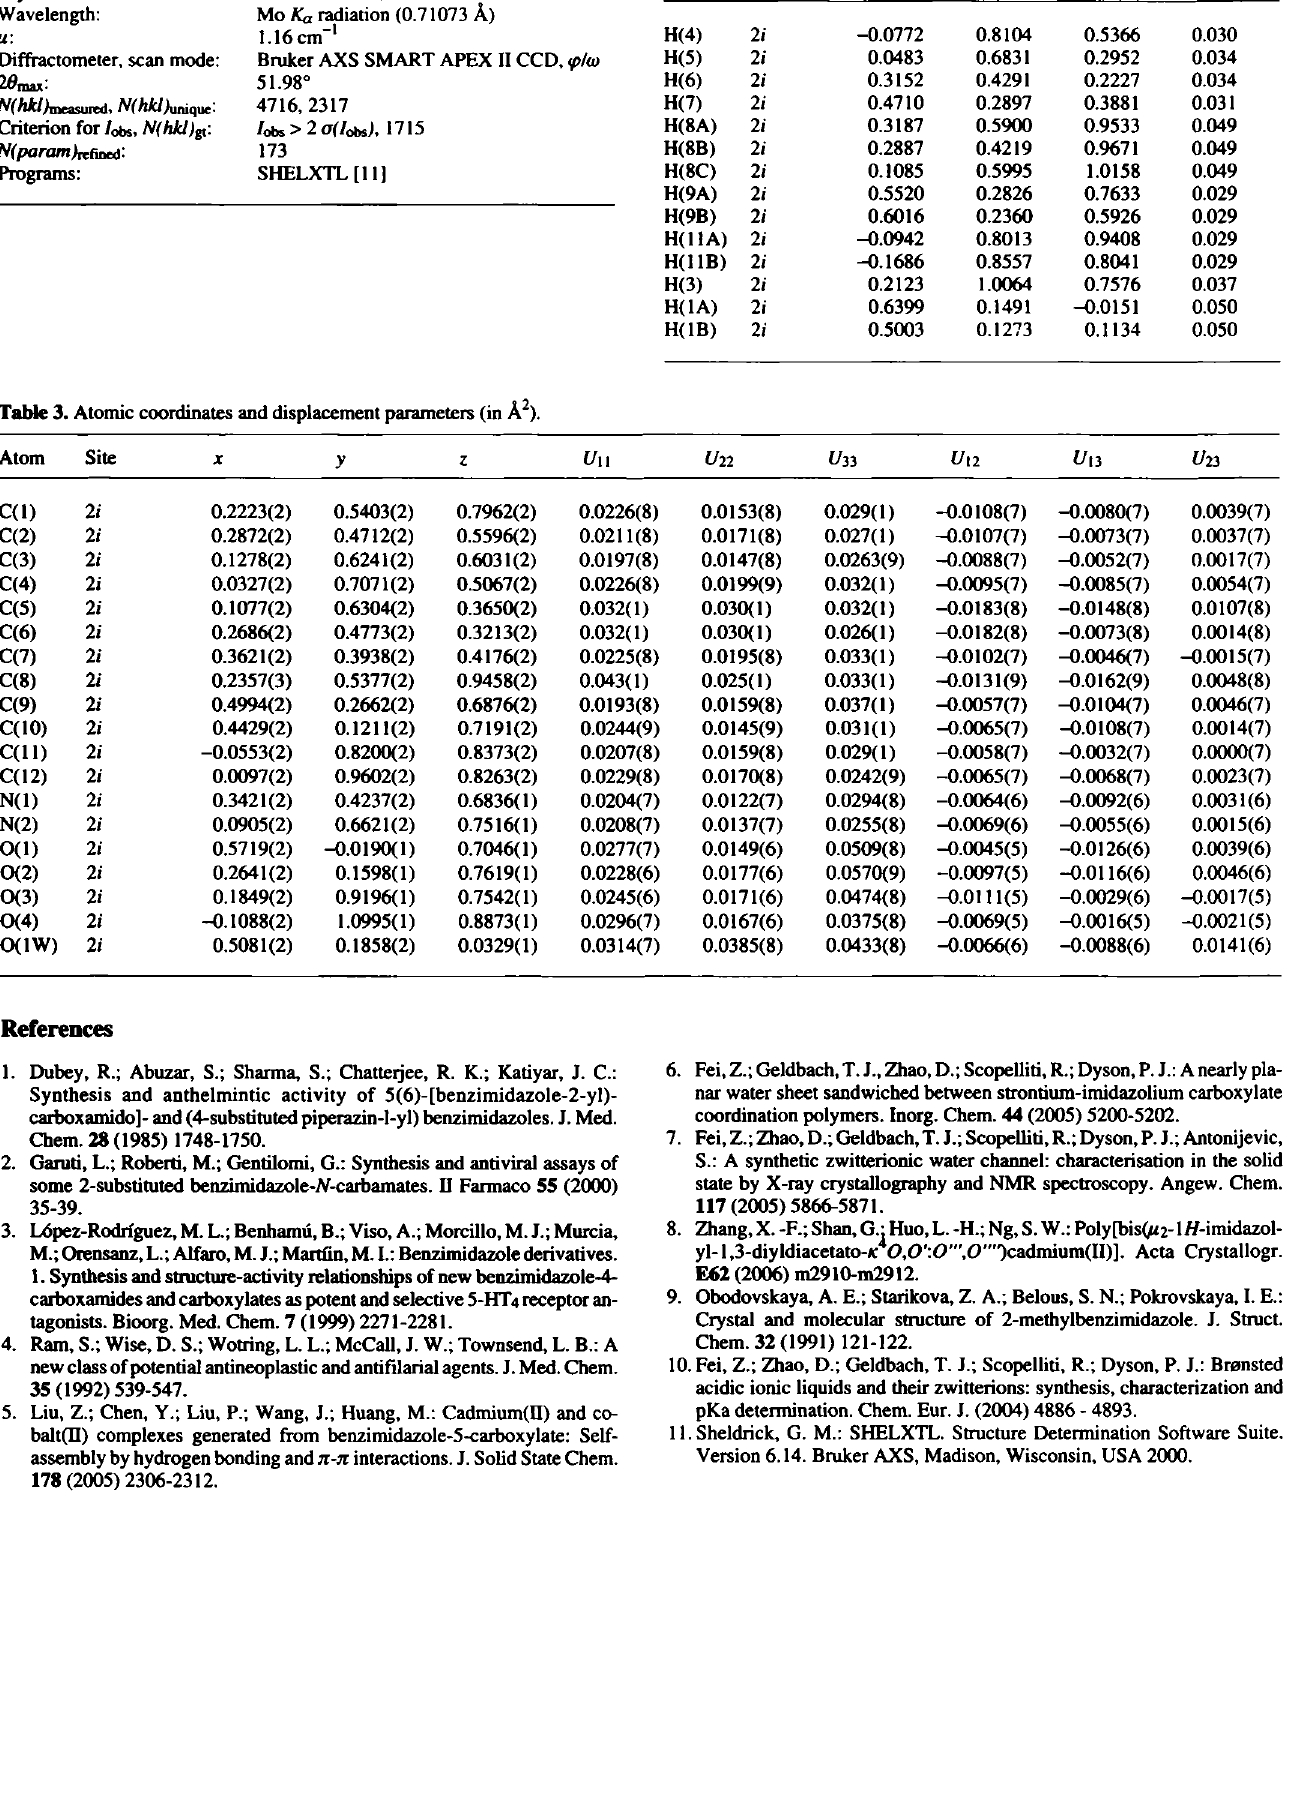
Table 3. Atomic coordinates and displacement parameters (in Â 2